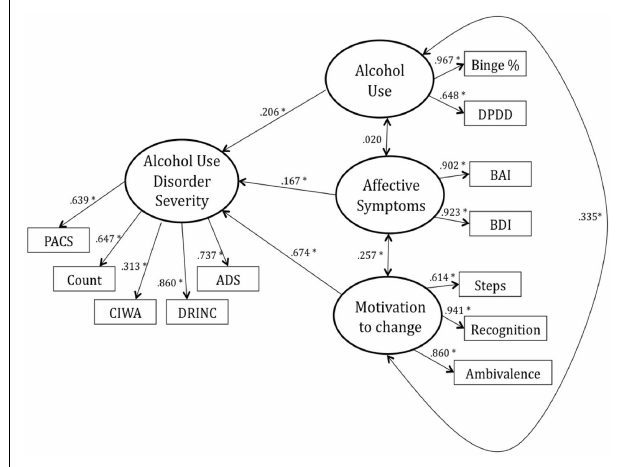
FIGURE 1 |The final estimated model with standardized path coefficients (ß) .The following results are based on the final model with the standard significance threshold at p <